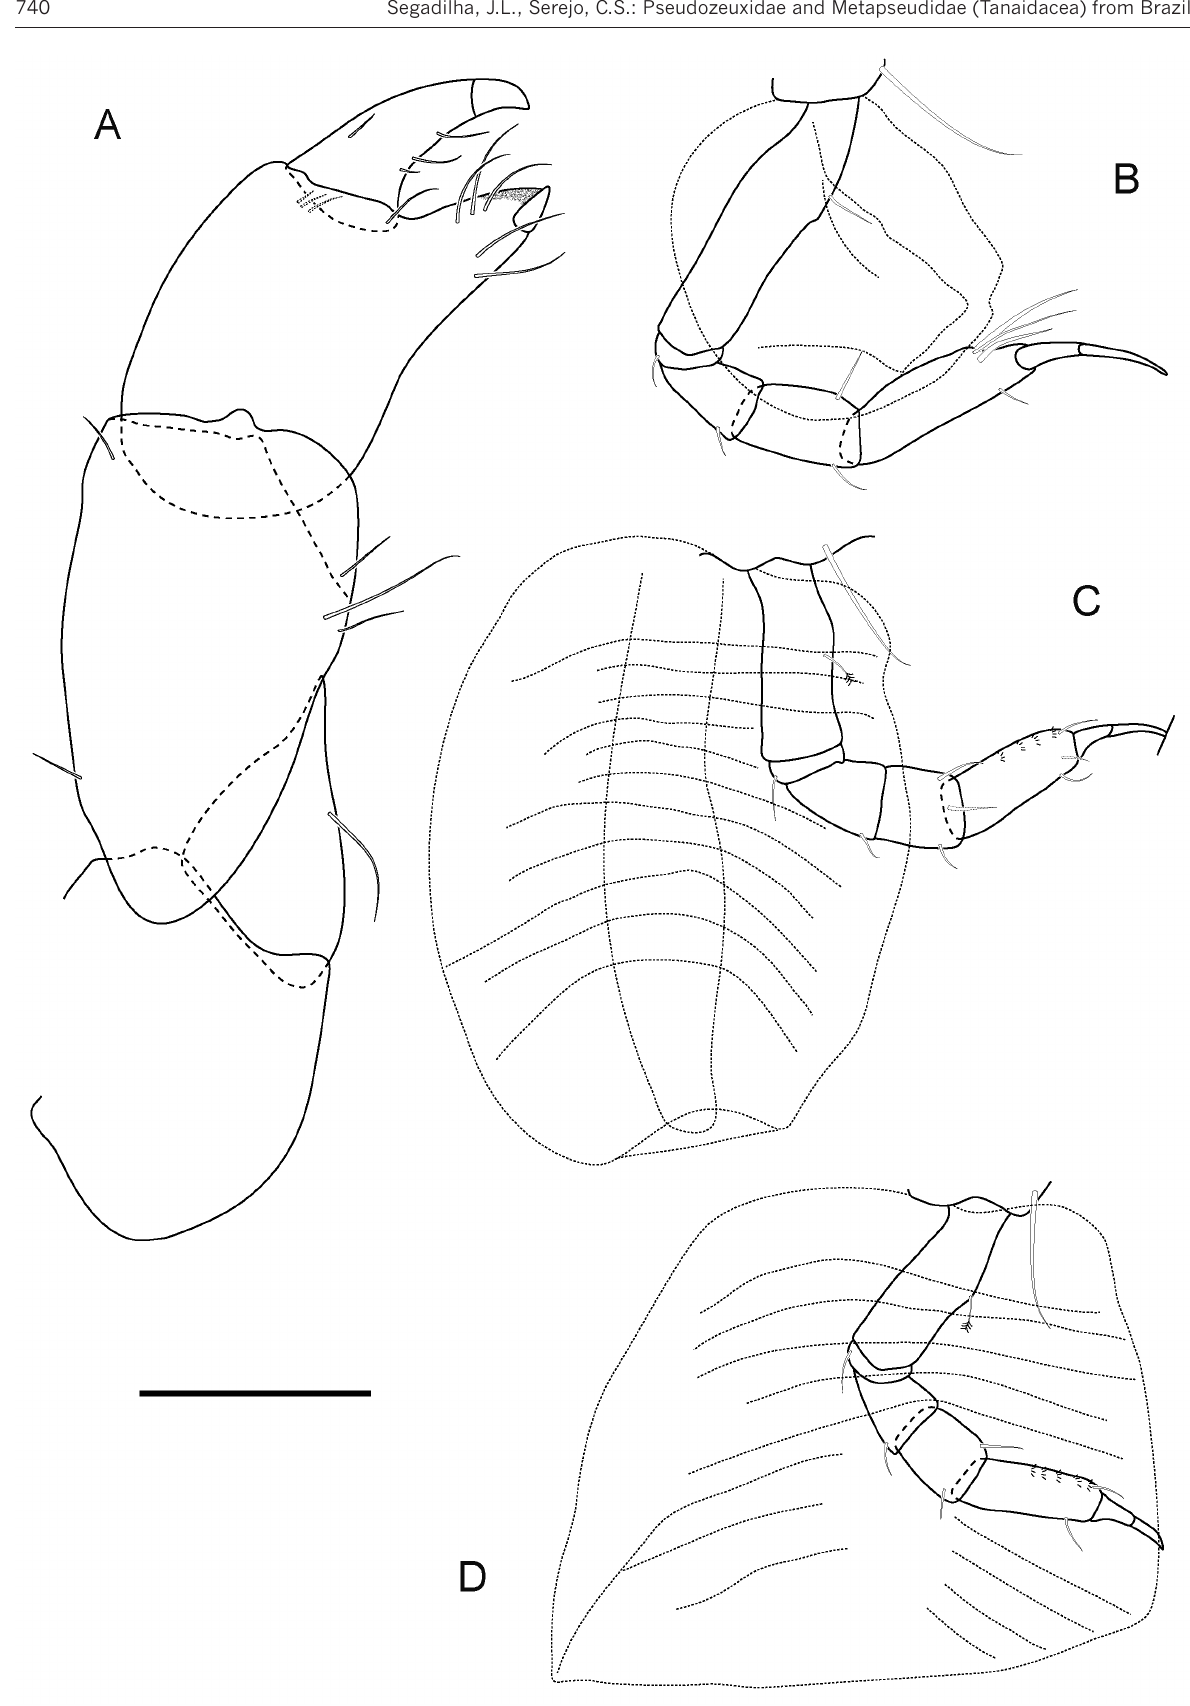
Figure 11. Pseudozeuxo fischeri sp. nov. Paratype, female dissected (MNRJ 29869). A Cheliped; B–D pereopods 1–3 with ooste- gites. Scale bar: 0.1